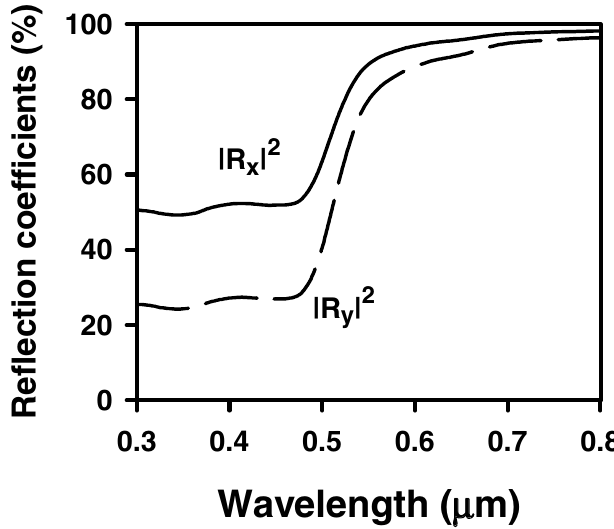
FIG. 9. Reflection coefficients for gold: vertical (dashed line) and horizontal (solid line) polarization